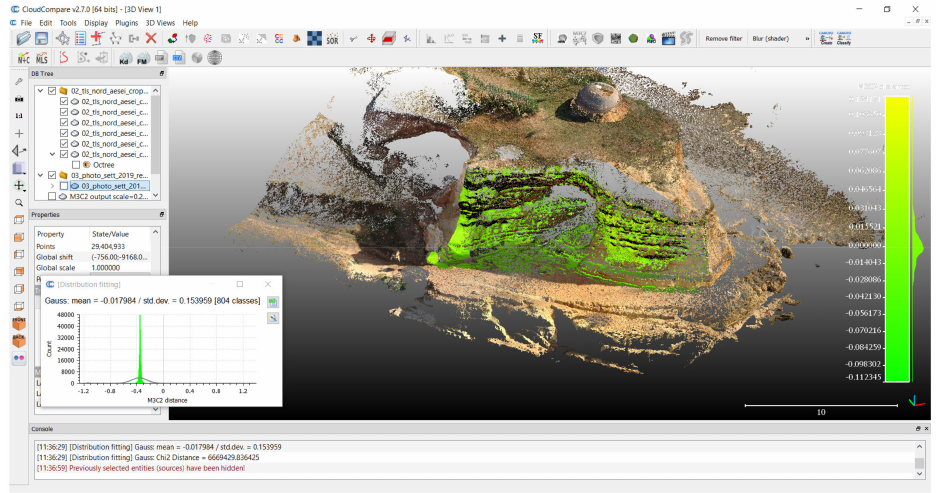
Figure 22. Analysis of the variation of distances, using the M3C2 algorithm, in Cloud Compare. Different results were obtained in Geomagic Studio Software. In the latter software, dedicated to the processing of point clouds, the comparison of distances is performed using the 3D Compare tool. The tool, with the sampling ratio set to 100%, calculates a deviation value for each vertex in the measured data. Each measured vertex is defined by a measured position (P m = x m , y m , z m ) associated with a reference position (P r = x r , y r , z r ), which is defined by the projection direction (shortest, longest normal, custom). For each measured point, the tool calculates a gap vector (GV), which goes from P r to P m , as shown